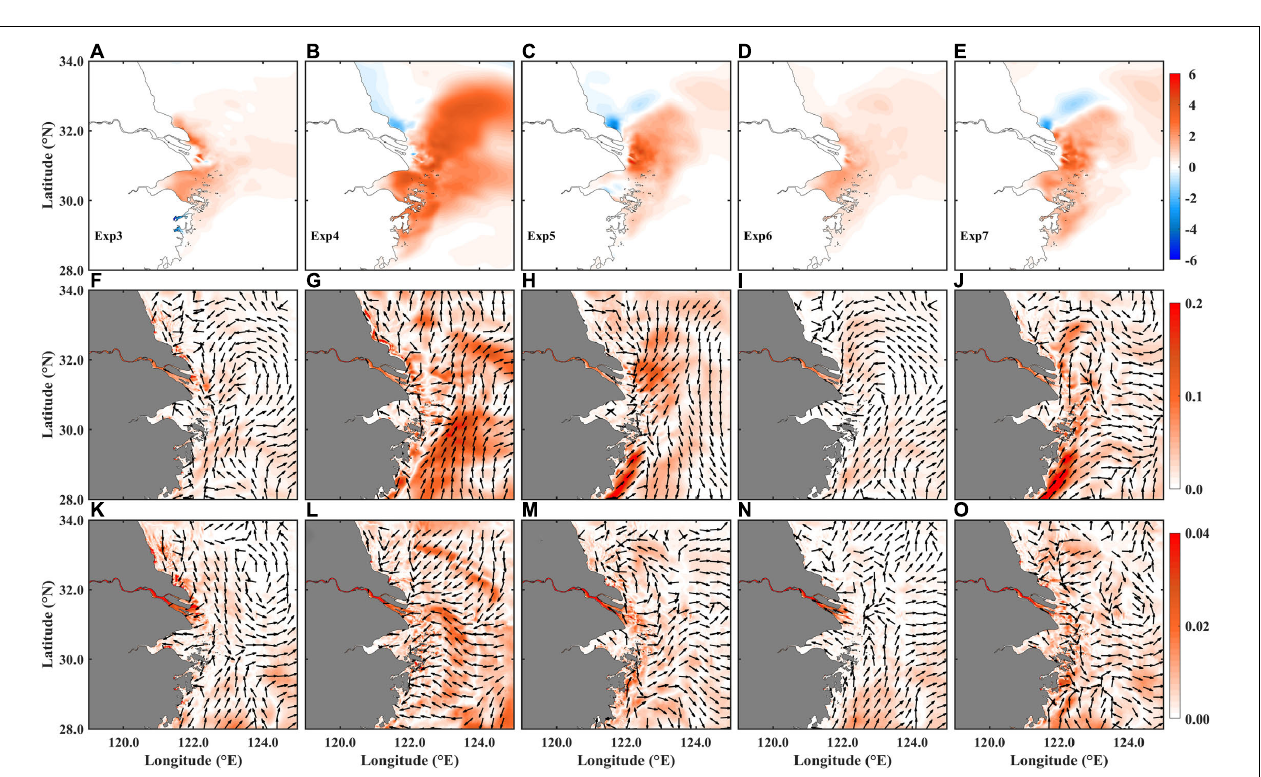
FIGURE 12 | The daily-averaged surface salinity (black lines indicate 24, 26, 28, and 30 psu) and PEA (unit: kg · m − 1 s − 2 ) calculated from July 11 to 16 in (A–F) Exp1 (CR) and (G–L) Exp2 (NoWave).